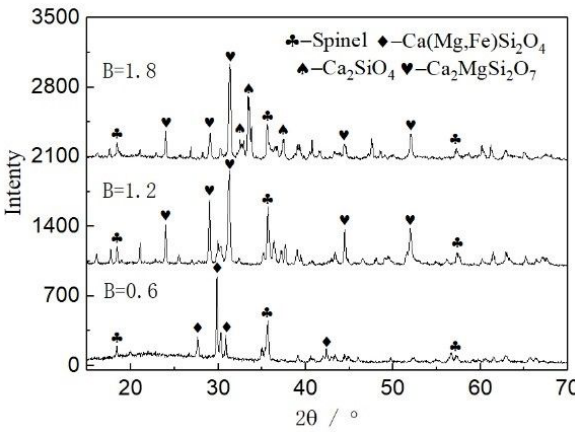
Figure 5: XRD diffraction patterns of the samples.